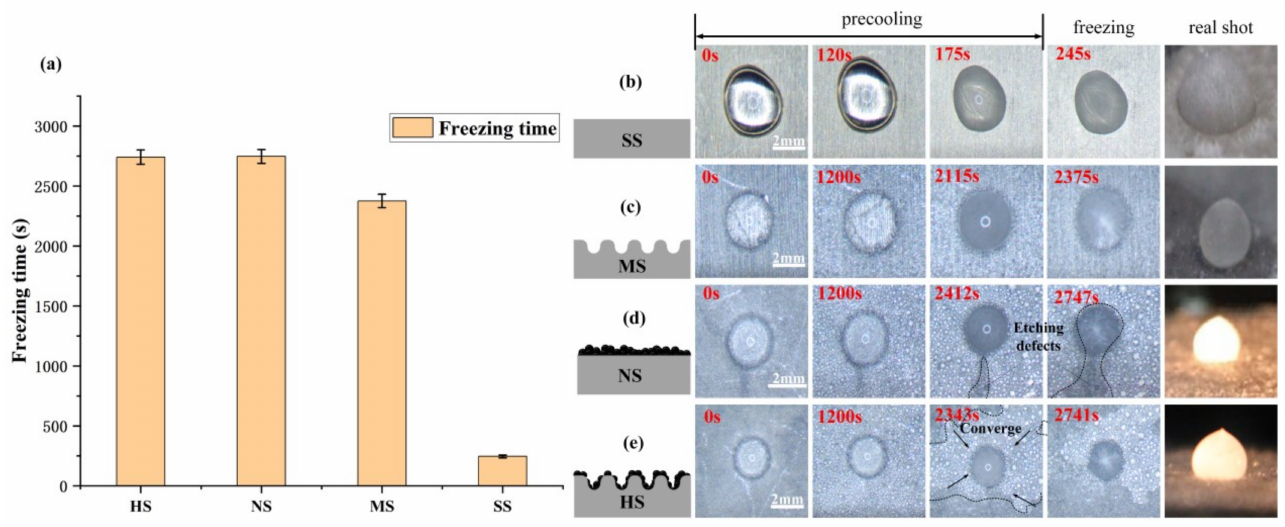
Figure 5. Ice conditions of four samples, ( a ) Ice conditions of SS; ( b ) ice conditions of MS; ( c ) ice conditions of NS; ( d ) ice conditions of HS; ( e ) histogram of freezing time of four samples.